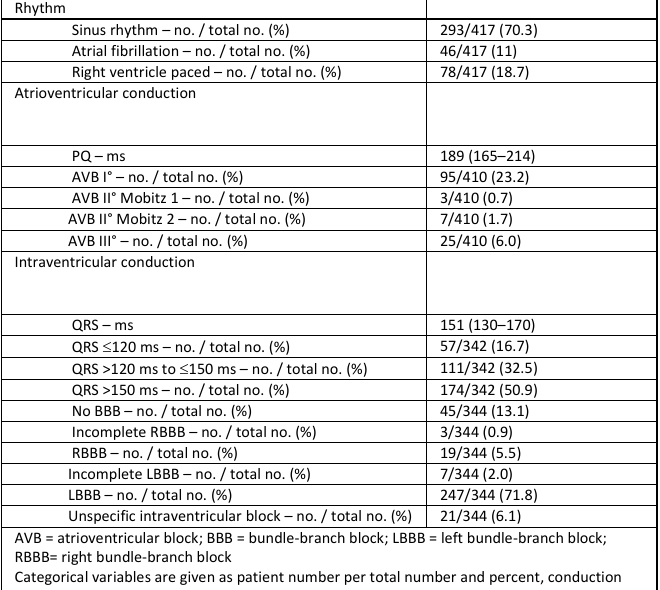
Table S4: Electrocardiographic characteristics at the time of cardiac resynchronisation therapy device implantation. Rhythm Sinus rhythm – no. / total no.